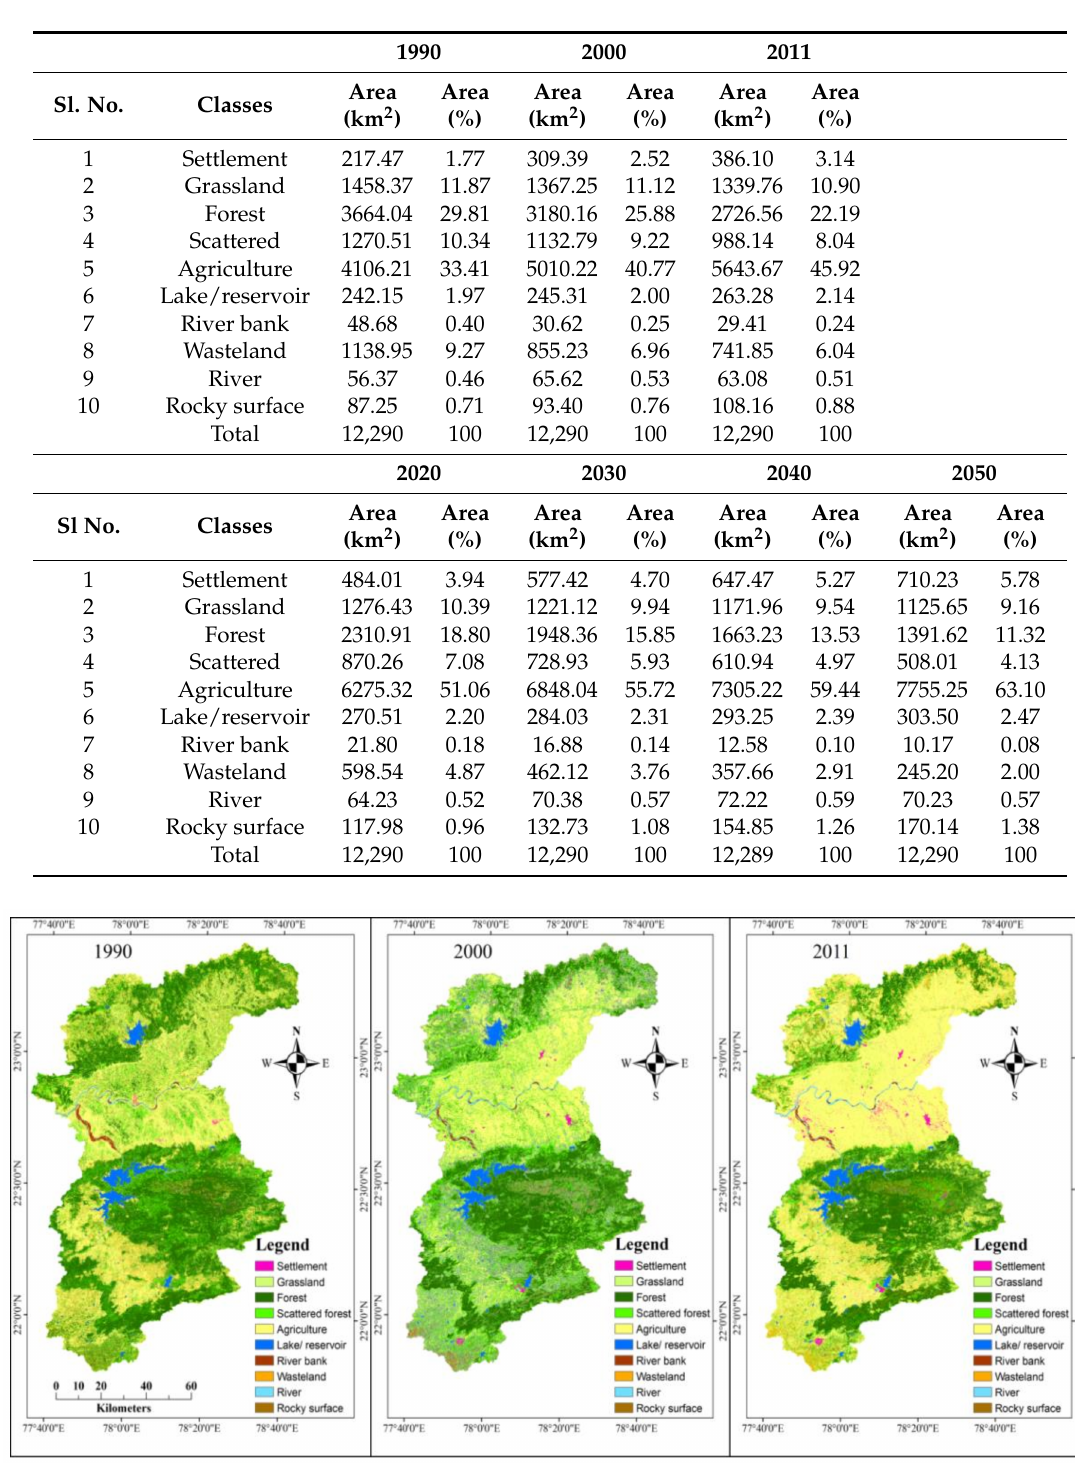
Figure 6. Land use maps of 1990, 2000, and